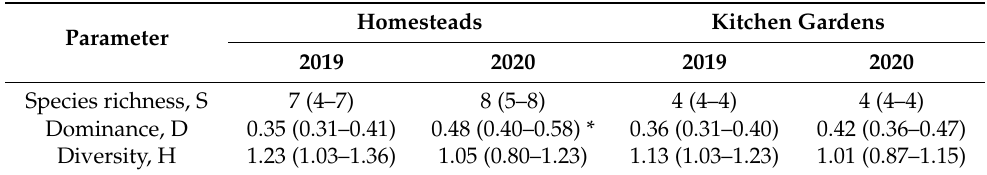
Table 1. Main parameters of small mammal diversity in the homestead and kitchen garden, 2019–2020 (bootstrap estimation in parentheses). Significant differences between years marked with